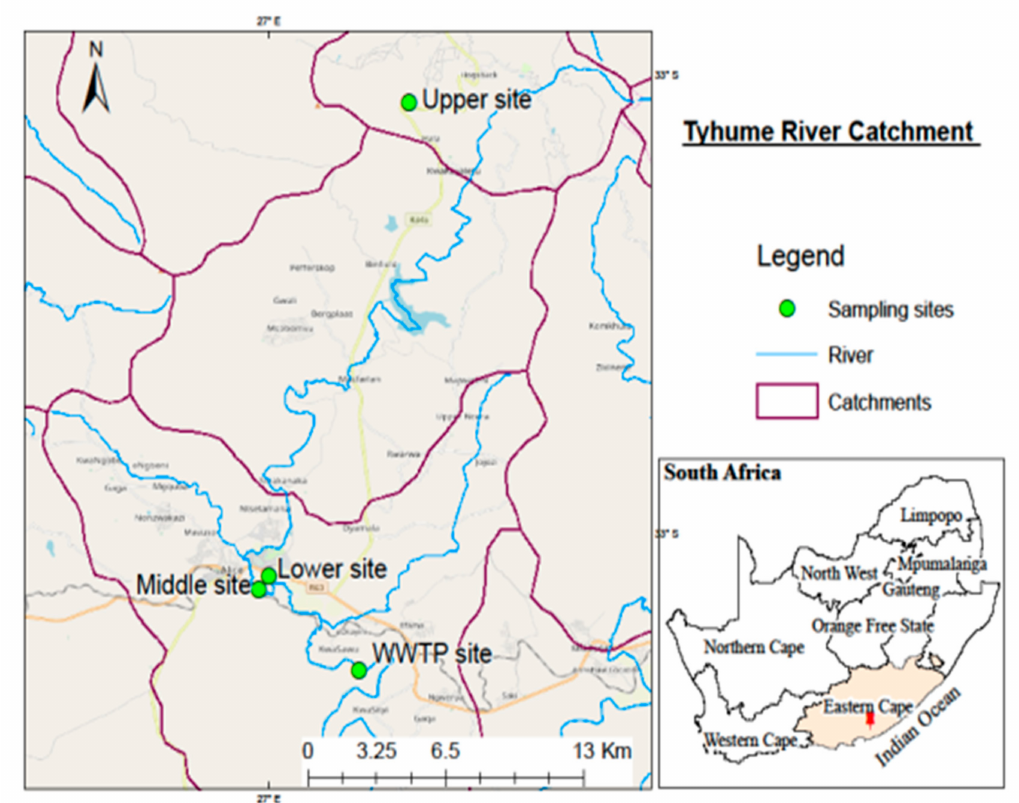
Figure 2. The map of the Tyhume River Catchment demonstrating the study region with sampling sites.